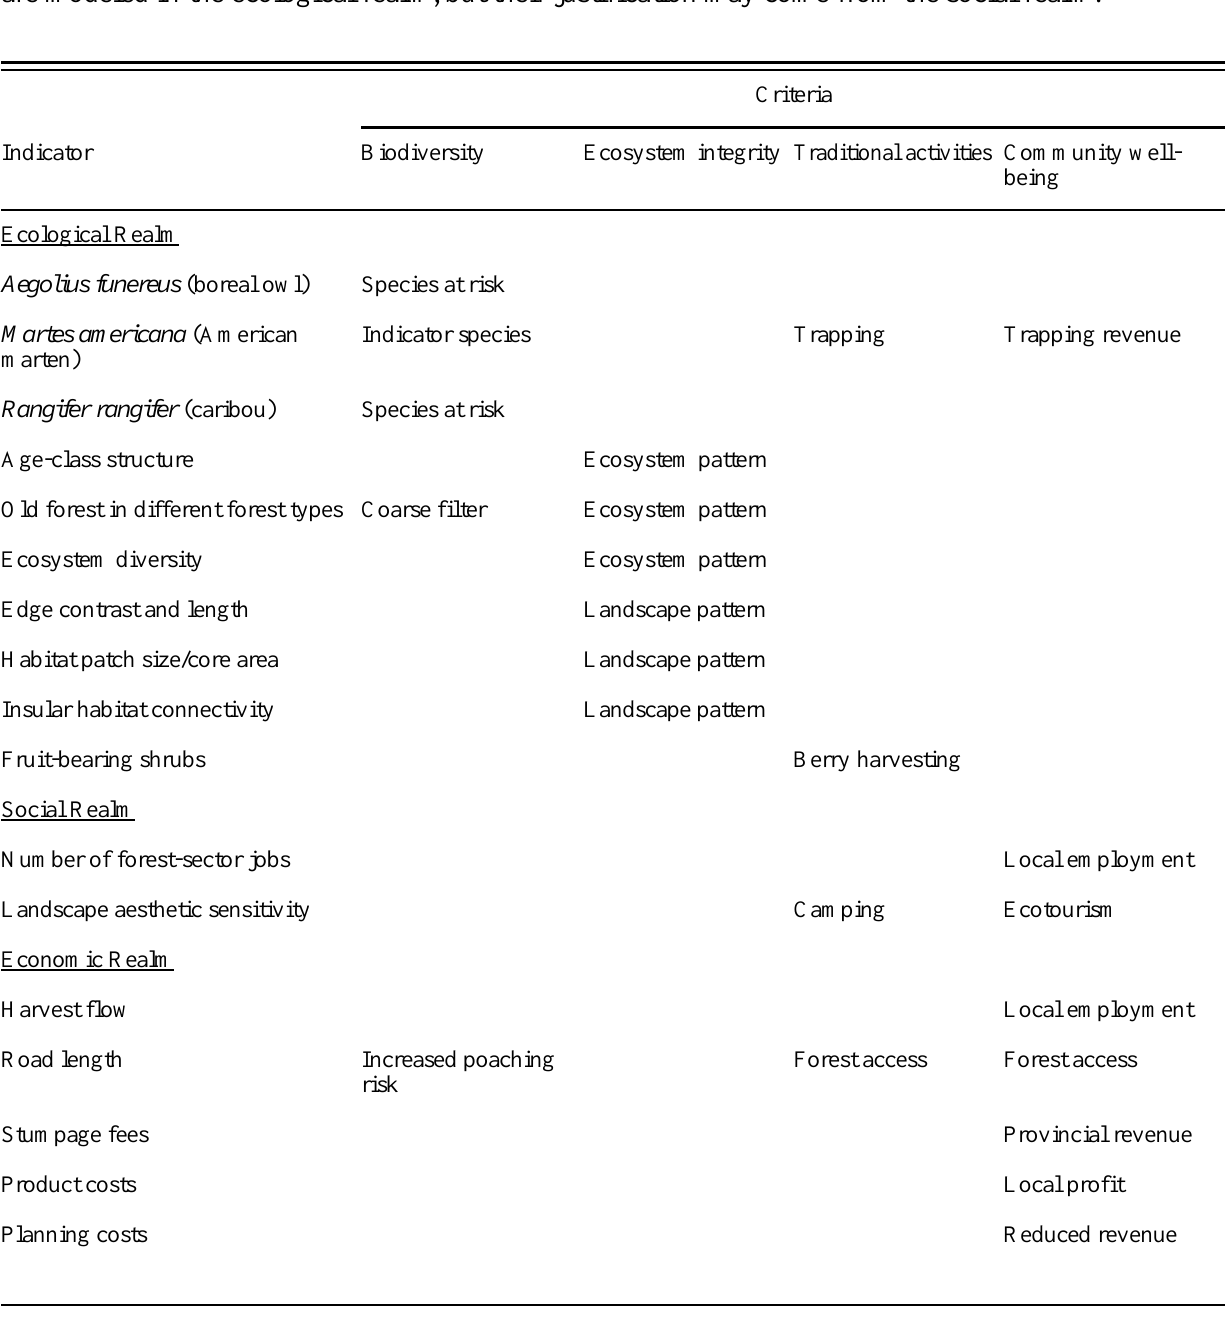
Table 2. Examples of indicators to be used in the Labrador test case, derived from local consultation sessions led by members of the modeling team, including justification for the criteria they indicate. Many indicators are modeled in the ecological realm, but their justification may come from the social